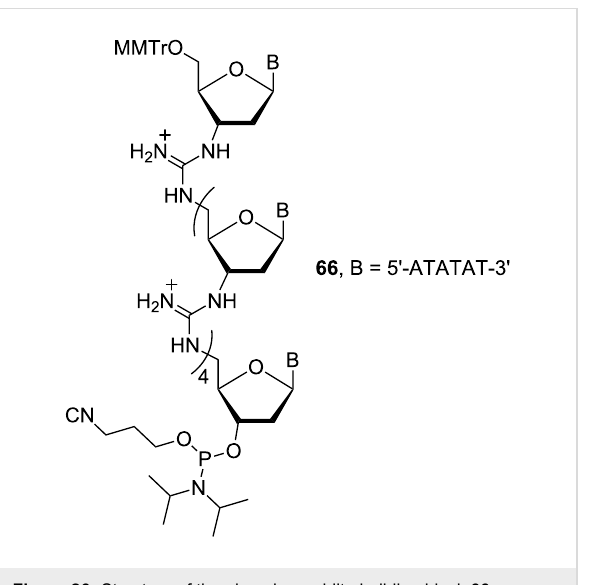
Figure 26: Structure of the phosphoramidite building block 66